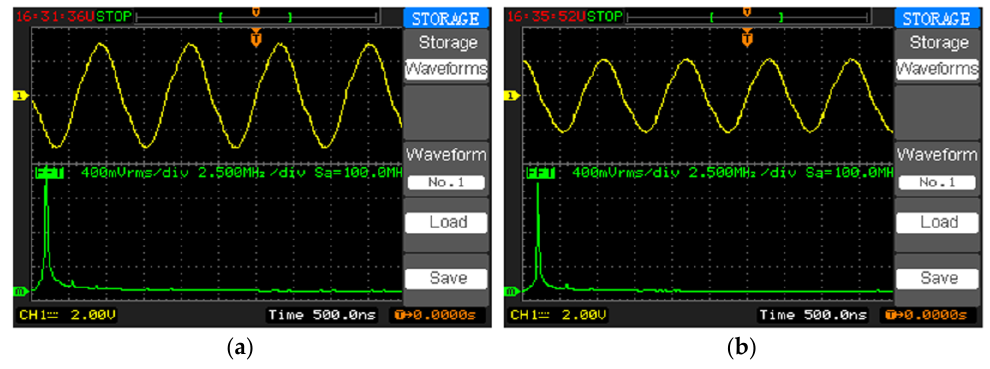
Figure 13. Measured voltage signals and frequency spectra at the receiver coil when the system is loaded with resistive loads of 100 Ω at ( a ) 6 cm and ( b ) 15 cm.